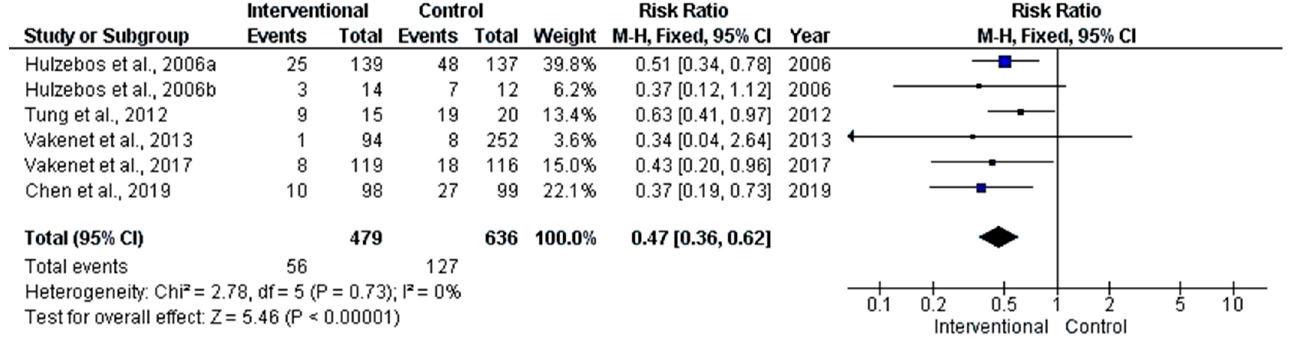
Figure 9. Forest plot evaluating PPCs in the included studies.